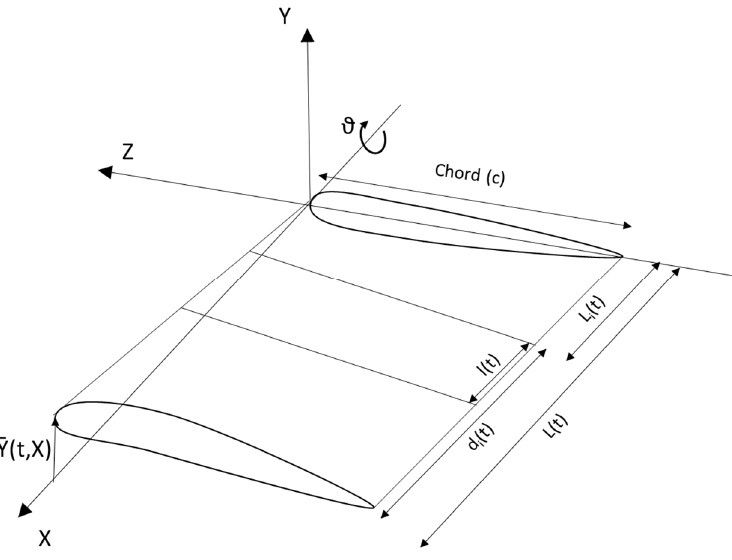
Figure 4. Schematic for cantilever beam with time-varying length